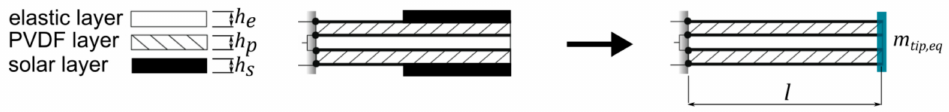
Figure 3. First modelling approach used in the current study where solar panels are represented as an equivalent concentrated tip mass. Equivalent tip mass is highlighted in